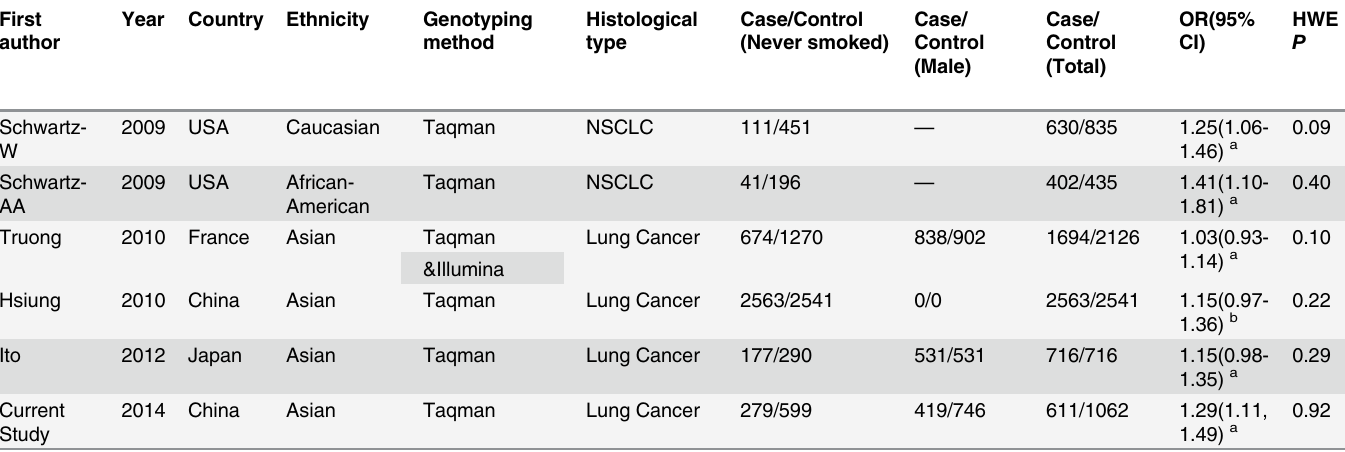
Table 3. The characteristics of included